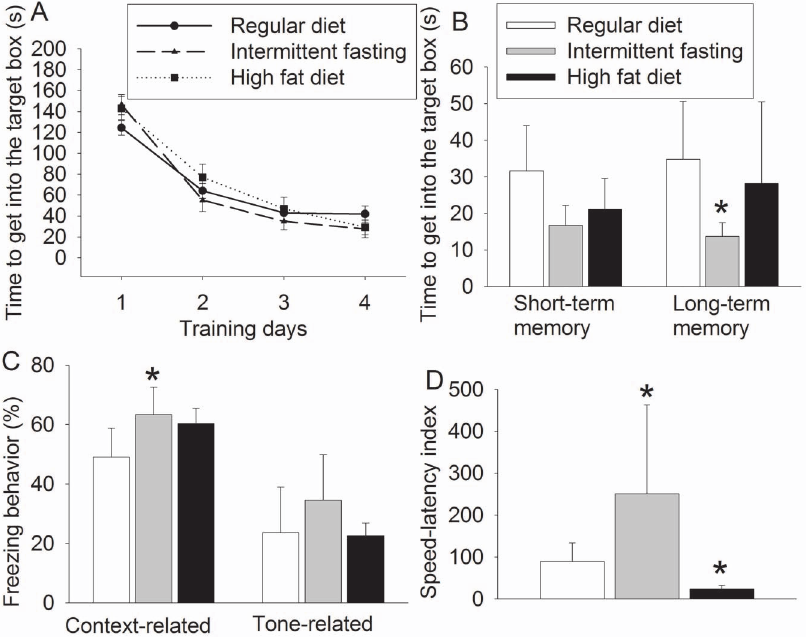
Figure 2. The effects of various feeding protocols on leaning and memory. Seven-week old male mice had free access to regular chow or high fat diet or were allowed to have free access to regular chow every other day (intermittent fasting) for 11 months. They were then subjected to Barnes maze, fear conditioning and rotarod tests. The results in the training sessions and memory phase of the Barnes maze are presented in panels A and B. The fear conditioning and rotarod results are shown in panels C and D, respectively. Results are means 6 S.E.M (n=15 – 35). * P , 0.05 compared with mice on regular chow ad libitum .